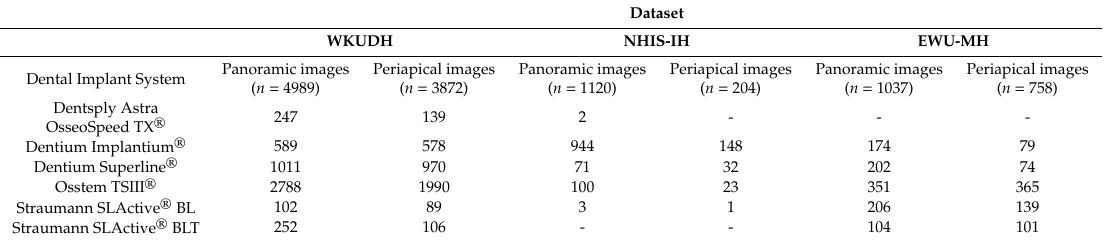
Table 1. Number of panoramic and periapical radiographic images for each dental implant system (DIS).